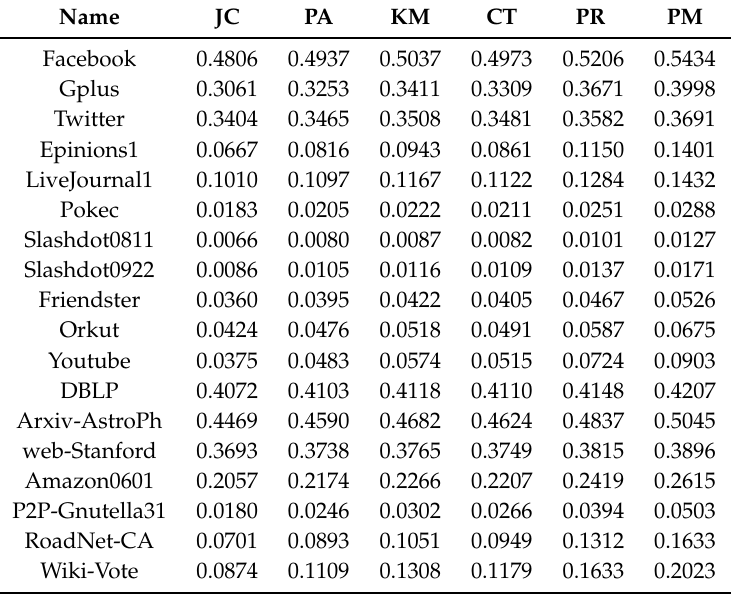
Table 3. Experiment 1: Experiment with nearness